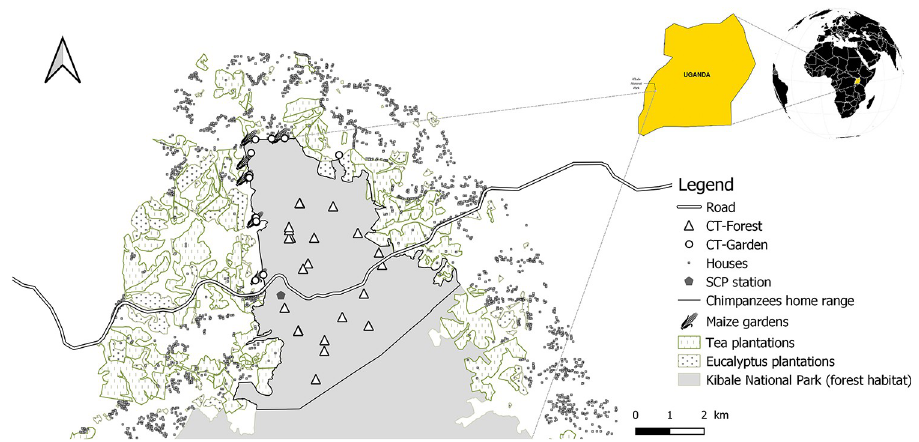
Fig 1. Map of Sebitoli chimpanzee forest home range and surrounding cultivated fields, Kibale National Park (KNP), Uganda. Republished from [73] under a CC BY license, with permission from Revue Francophone de Primatologie, original copyright